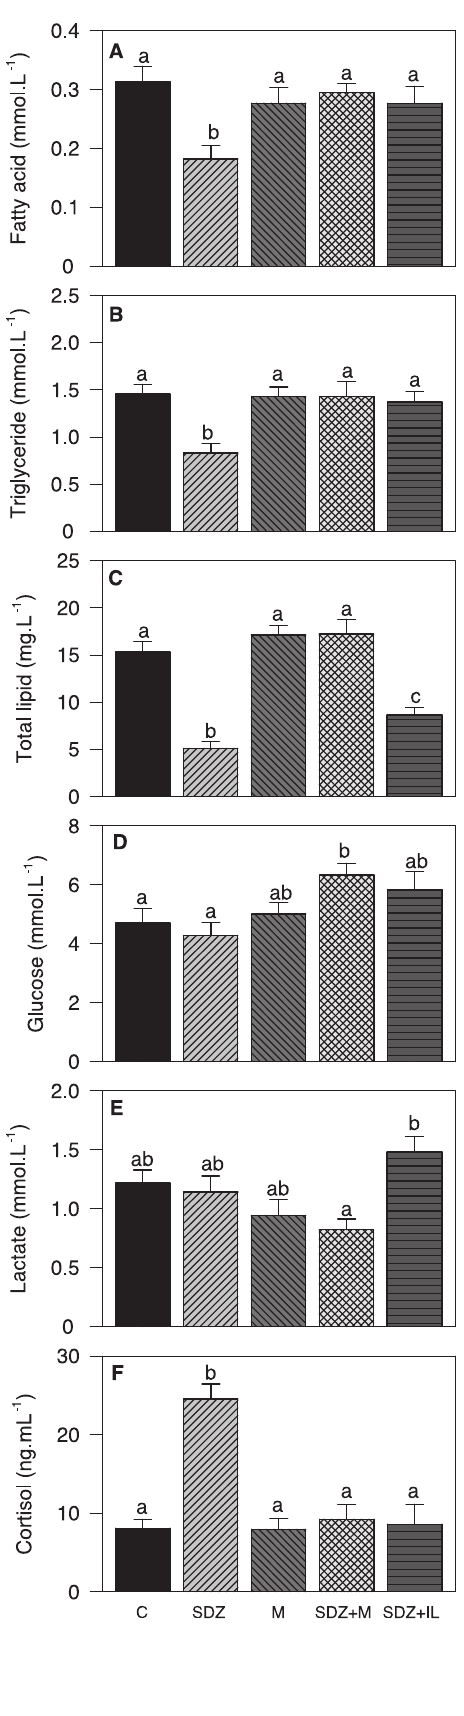
Figure 2. Changes in the levels of plasma metabolites after intraperitoneal treatment. Levels of fatty acid (A), triglyceride (B), total lipid (C), glucose (D), lactate (E), and cortisol (F) in plasma of rainbow trout after 6 h of intraperitoneal administration of 10 mL.Kg 2 1 of saline solution alone (control, C) or containing SDZ WAG 994 (SDZ, 60 m g.Kg 2 1 ), metyrapone (M, 1 mg.Kg 2 1 ), both SDZ WAG 994 and metyrapone (SDZ + M), or both SDZ WAG 994 and intralipid (3 mL.Kg 2 1 ) solution (SDZ + IL). The results are shown as mean + S.E.M. of 10 fish per treatment. Different letters indicate significant differences ( P , 0.05) among